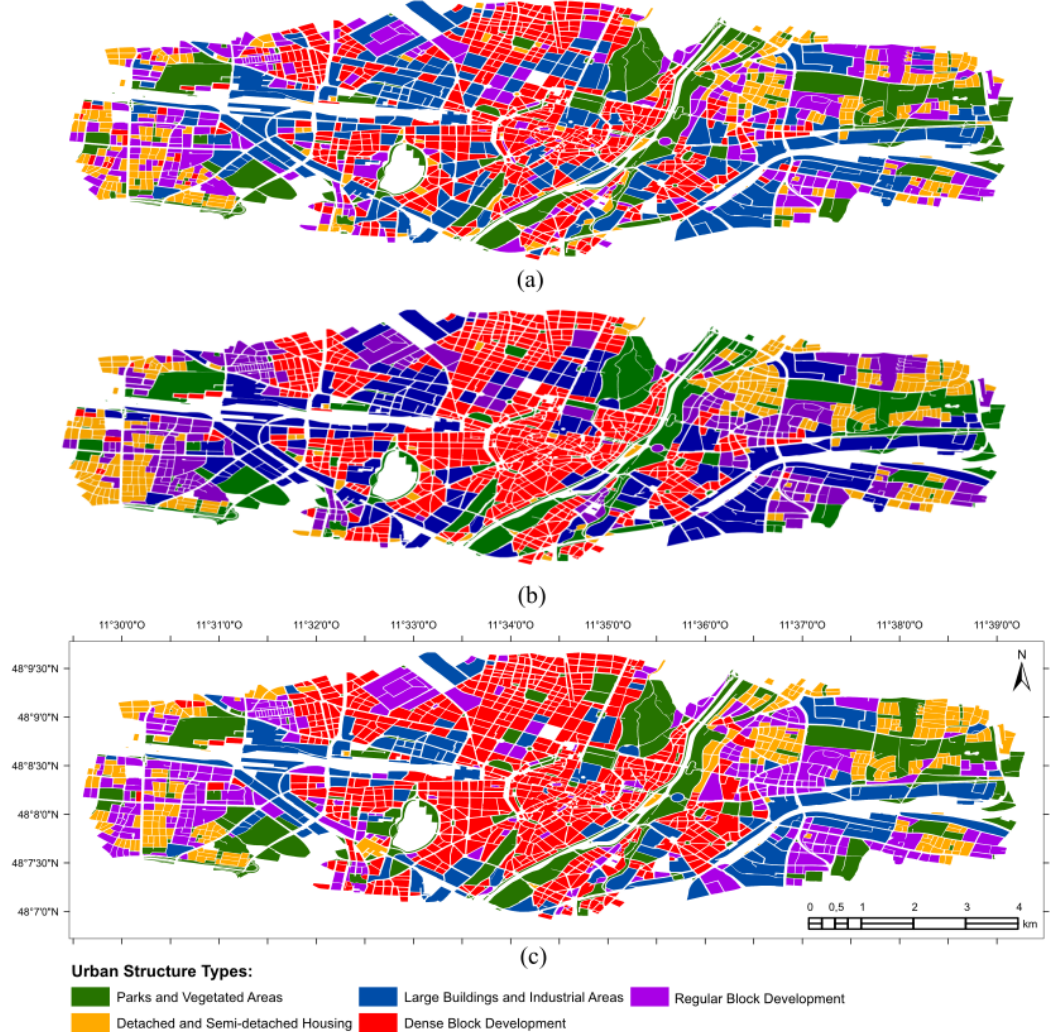
Figure 5. Ground-truth map and the standard and context-based classifications. ( a ) Standard classification performed with the Random Forest algorithm, i.e., without considering